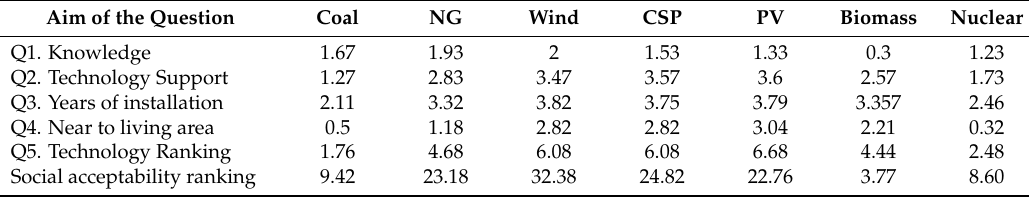
Table 5. Collective responses on social acceptability from the online